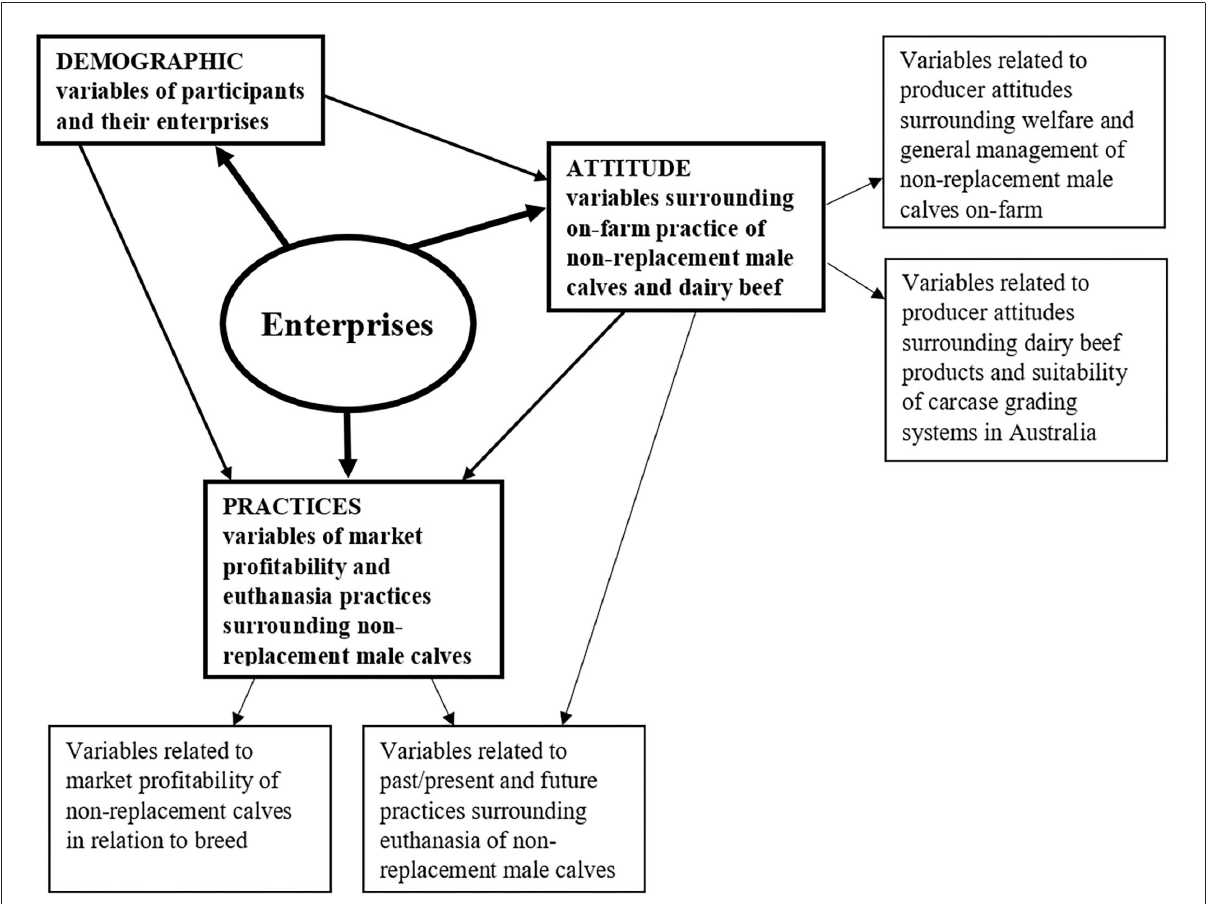
FIGURE1 Schematic diagram of the conceptual model that informed the development of the Bayesian network to describe the interrelationships between producer demographics, practices, and attitudes of non-replacement male calf management in the Australian dairy industry.